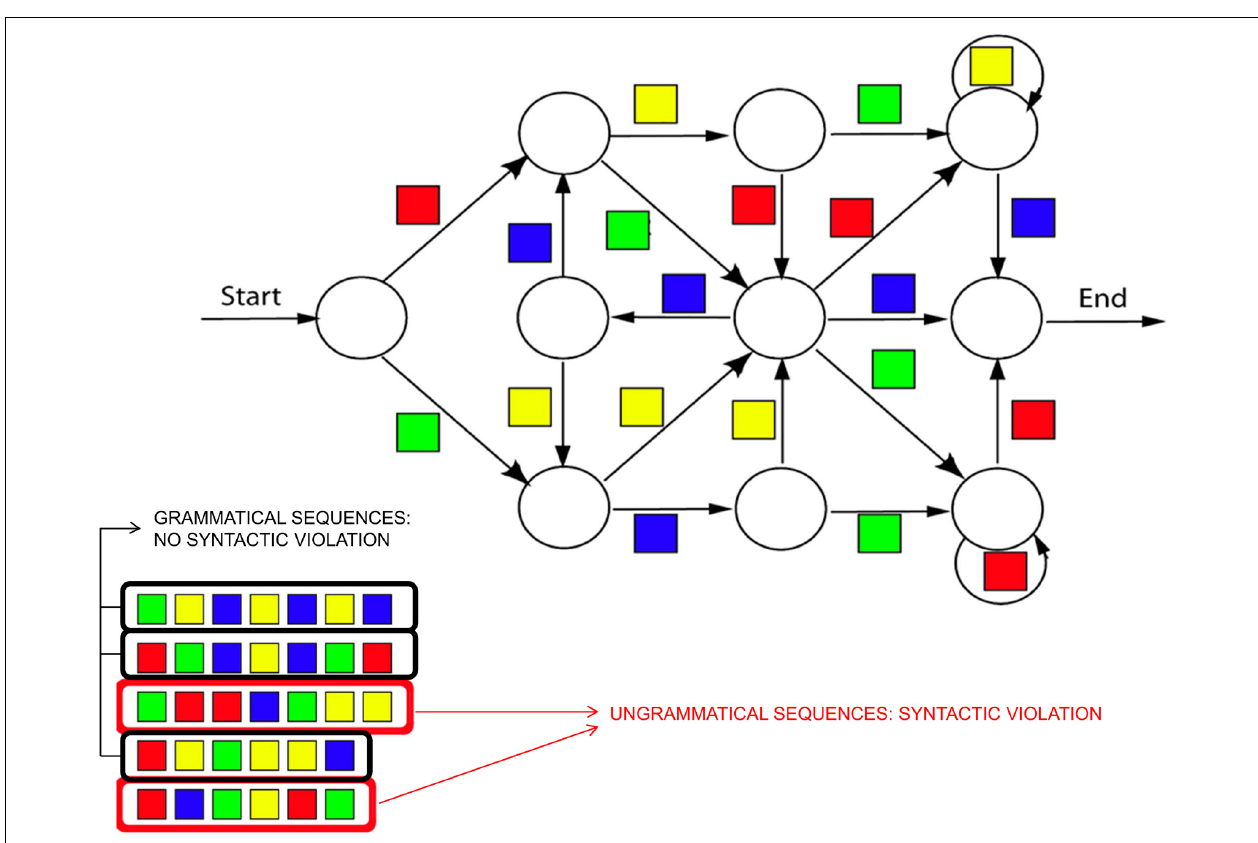
FIGURE 7 | Example of an artificial grammar in the visual domain. The algorithm describes the rules of the artificial grammar, that is the set of possible sequences of stimuli (in this case, colored squares) that are valid according the rules of the grammar. Examples of valid sequences